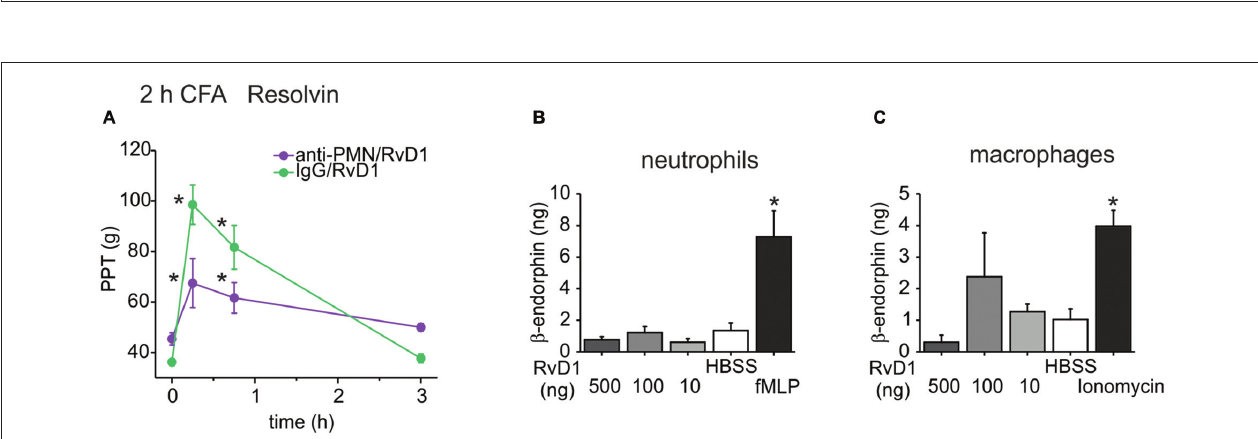
FIGURE 3 | Leukocyte dependency of RvD1-mediated antinociception in early states of CFA-induced hind paw inflammation. Antinociception by RvD1 (A) was prevented in part in leukocyte-depleted Wistar rats. Leukocyte depletion was achieved by systemic anti-PMN (i.p.) treatment as described before (Rittner et al., 2006), IgG isotype antibody served as control. Mechanical hypersensitivity was measured at indicated time points before and after local RVD1 injection. ( n = 4–6 per group, mean ± SEM; two-way ANOVA RM post hoc Holm-Sidak, ∗ p < 0.05 compared to baseline pre-injection values, 0 h). (B,C) Release of β -endorphin from peritoneal neutrophils (B) and macrophages (C) of Wistar rats was not stimulated by different concentrations of RvD1. β -endorphin release (ng/ml per 1 × 10 7 cells) was measured with a commercially available ELISA after stimulation of isolated cells by RvD1 at indicated concentrations. Hank’s balanced salt solution (HBSS) served as negative control, fMLP ( B ; 1 µ M) or ionomycin ( C ; 10 µ M) as positive control ( n = 2–8 per group, mean ± SEM, one-way ANOVA post hoc Holm-Sidak, ∗ p < 0.05 compared to HBSS solvent control).